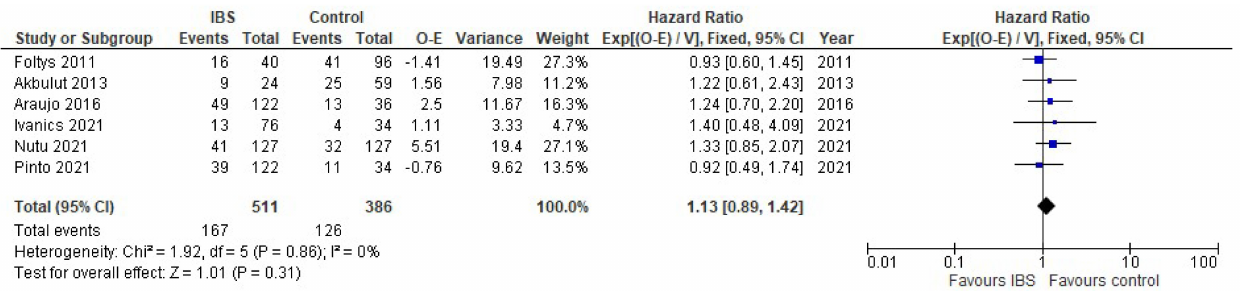
Figure 4. Forest plot for overall survival in liver transplant patients with IBS and without. Blue squares indicate individual effects and black diamond illustrates overall effect.